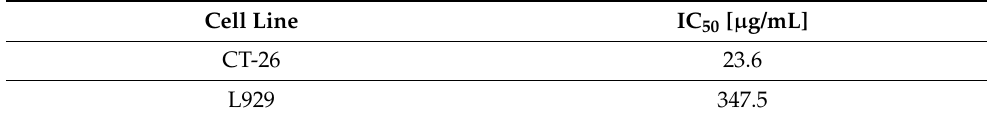
Table 1. IC 50 values of ex-LMS on CT-26 and L929 cell lines as determined during 48 h period of MTT assay, using non-linear, four-parameter regression